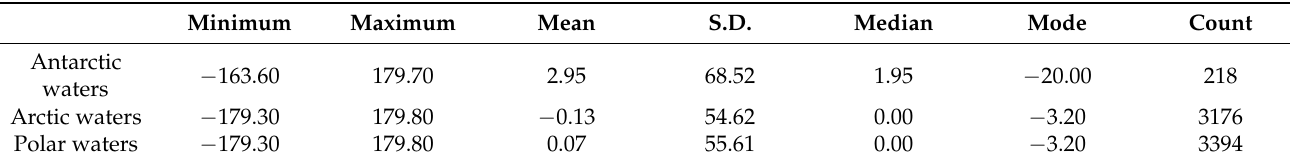
Figure 6. Box plot of the ship’s course variations in polar waters.